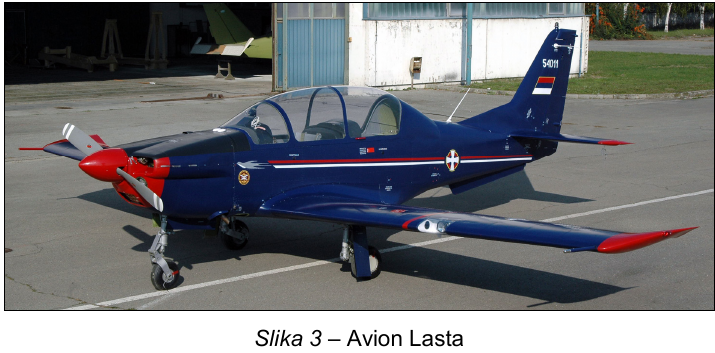
Slika 3 – Avion Lasta Figure 3 – Swallow